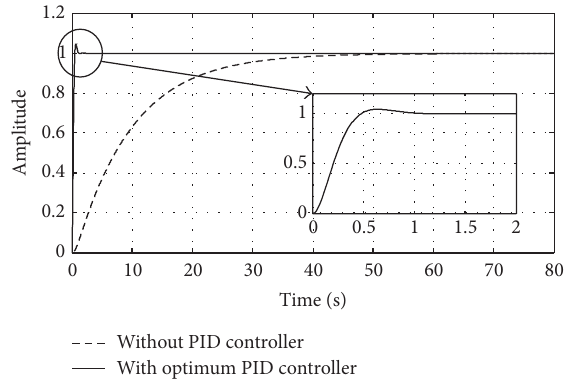
Figure 4: Step response of the DC motor with optimum PID controller